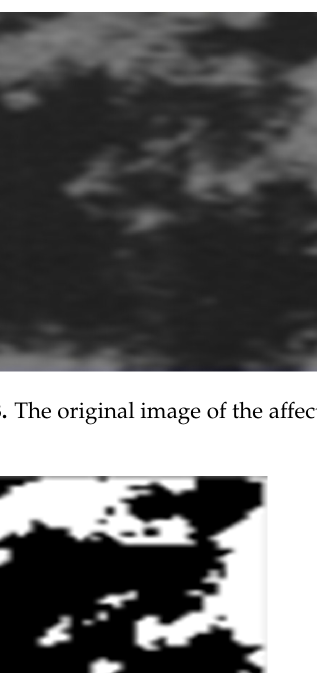
Figure 10. Applying the mask for lacunarity calculation. Following the numerical evaluations with the appropriate software of the image to affected/modified area, the values of fractal dimension D = 1.7411, standard deviation s = (cid:3399)√𝜎 (cid:2870) = (cid:3399)0.4568 , and lacunarity Λ = 0.0688 were obtained. Figure 11 shows the verification of the image in the affected/modified area with the Harmonic and Fractal Image Analyzer Demo software version 5.5.30 [21] of the fractal dimension of the area for various ruler scales r .